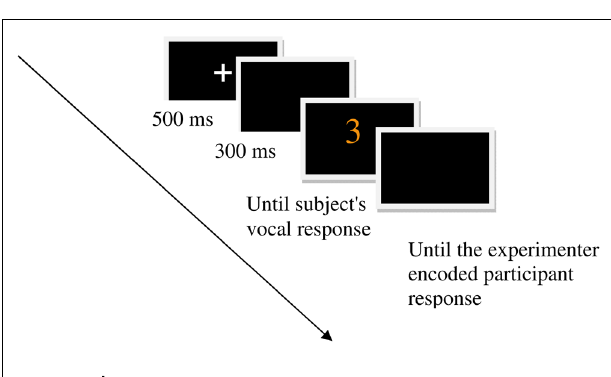
Hebrew University of Jerusalem Psychology Department, 2005).